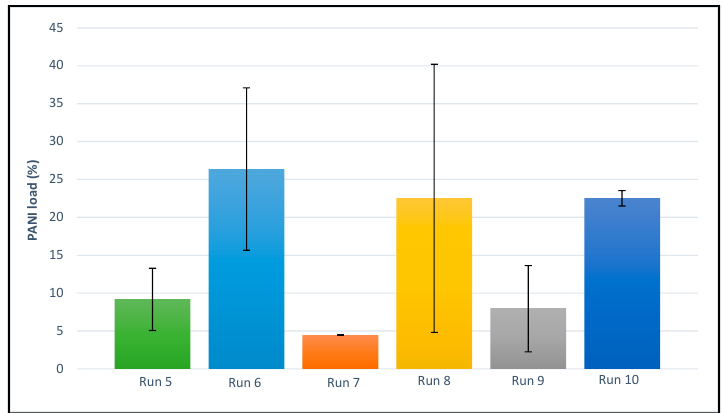
Figure 7. PANI loads incorporated into the structure of the final scaffolds.